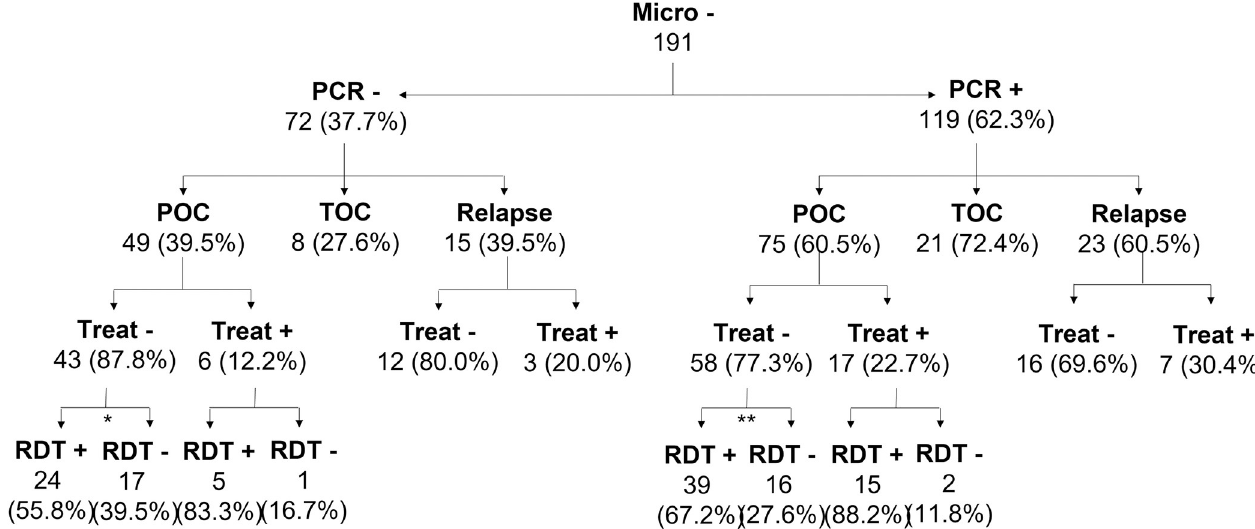
Fig 1. PCR results and treatment provided to patients with a negative microscopy test. The denominator for calculation of the proportion of POC, TOC and relapse samples that were PCR positive, was the total number of samples within that sampling stage; � 2 patients (4.1%) not tested by rK39, �� 3 patients (4.0%) not tested by rK39. Abbreviations : Micro , microscopy; POC , point of care/primary VL patients; TOC , test of cure after antileishmanial treatment , Treat , treatment provided or not; RDT , rK39 rapid diagnostic test positive or negative .